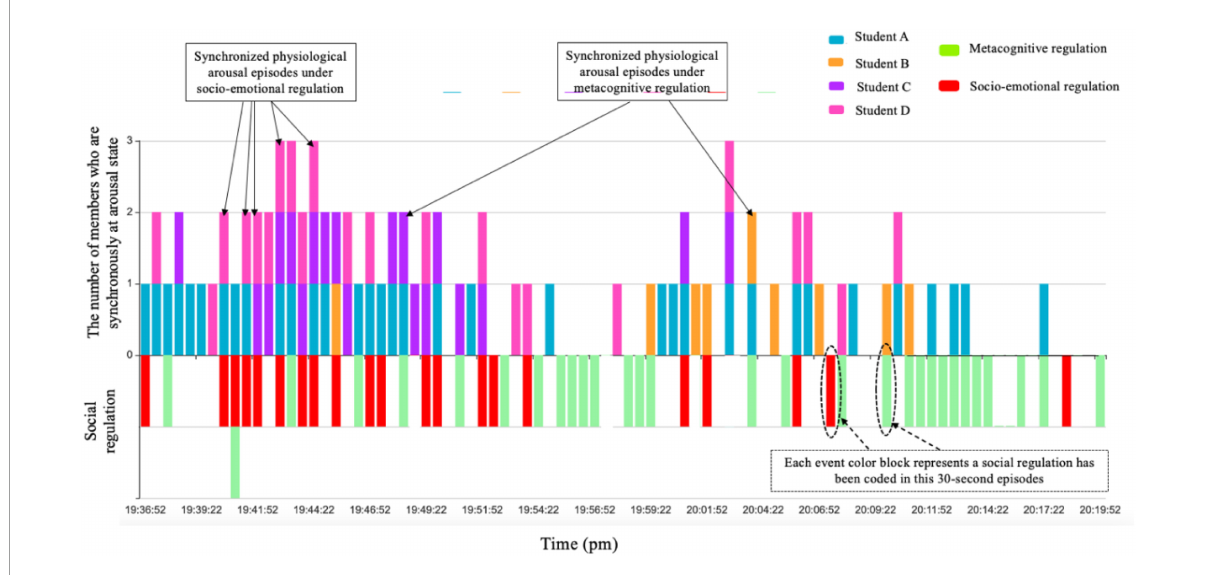
FIGURE6 How group members’ physiological arousal synchronized under different social regulations (example of group 4. The episodes where two or more arousal color blocks and event color blocks are superimposed are synchronized physiological arousal episodes under social